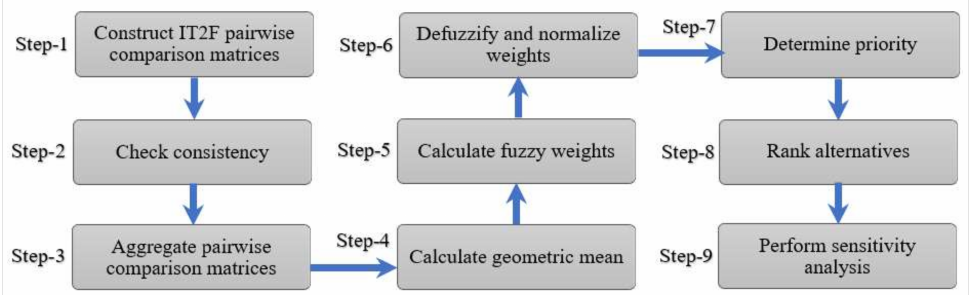
Figure 6. The steps taken for analyzing the data in this